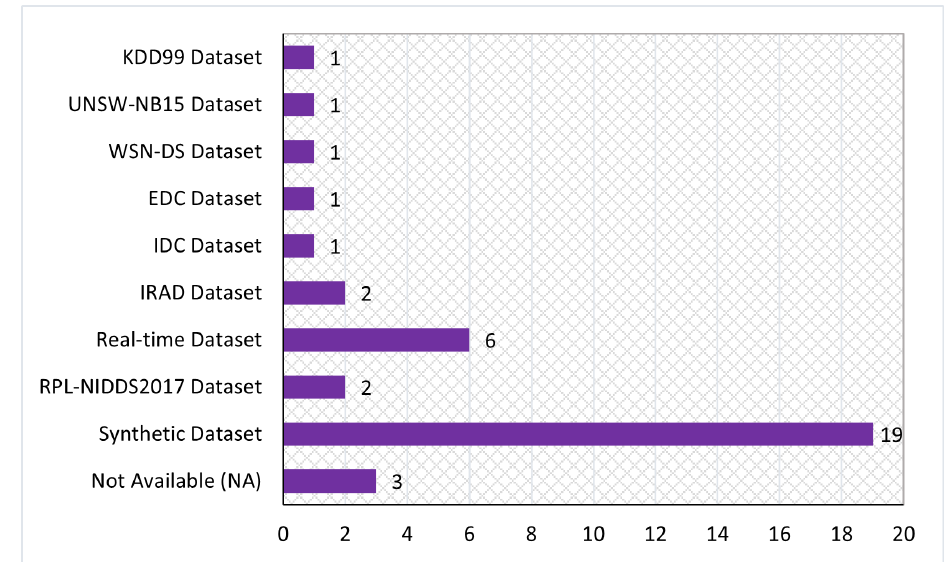
Figure 11. Occurrence of the datasets in the existing